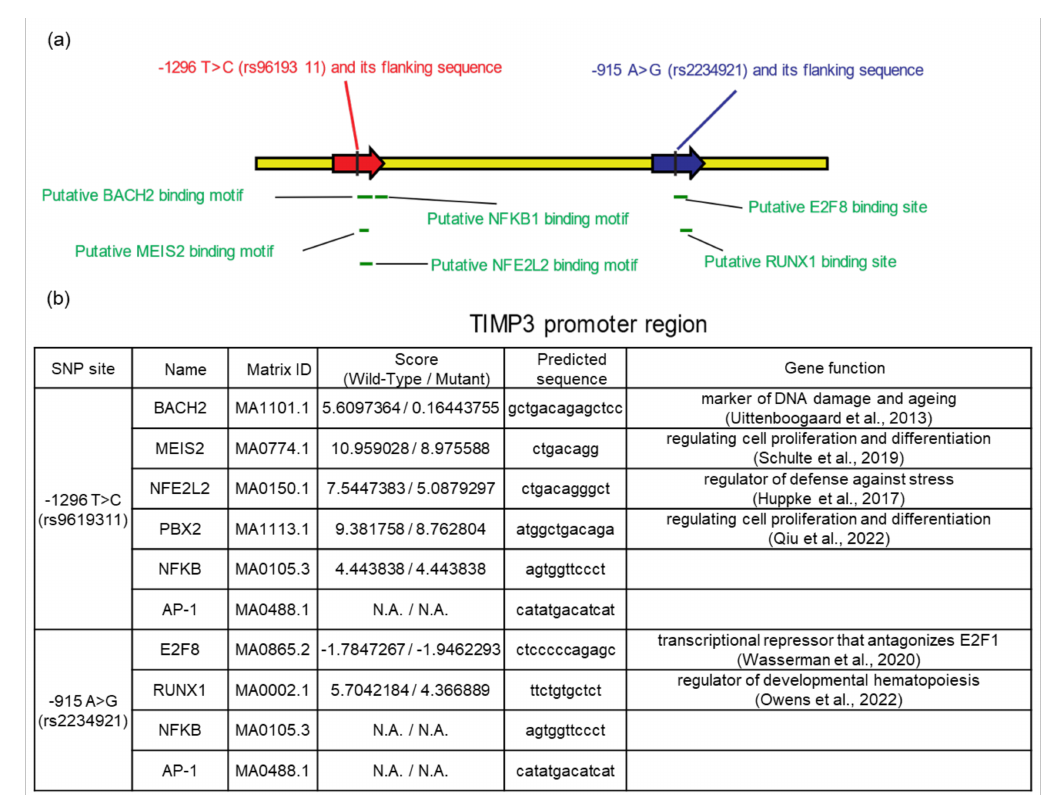
Figure 1. ( a ) rs9619311 and rs2234921 are, respectively, located within the predicted sequence of four and two transcription factor (TF) motifs. ( b ) TF-binding site scores were obtained using the JASPAR scan tool for the wild-type and mutant forms of each studied single-nucleotide polymorphism (SNP). For references of gene function: BACH2 [25], MEIS2 [26], NFE2L2 [27], PBX2 [28], E2F8 [29], RUNX1 [30]. N.A., not